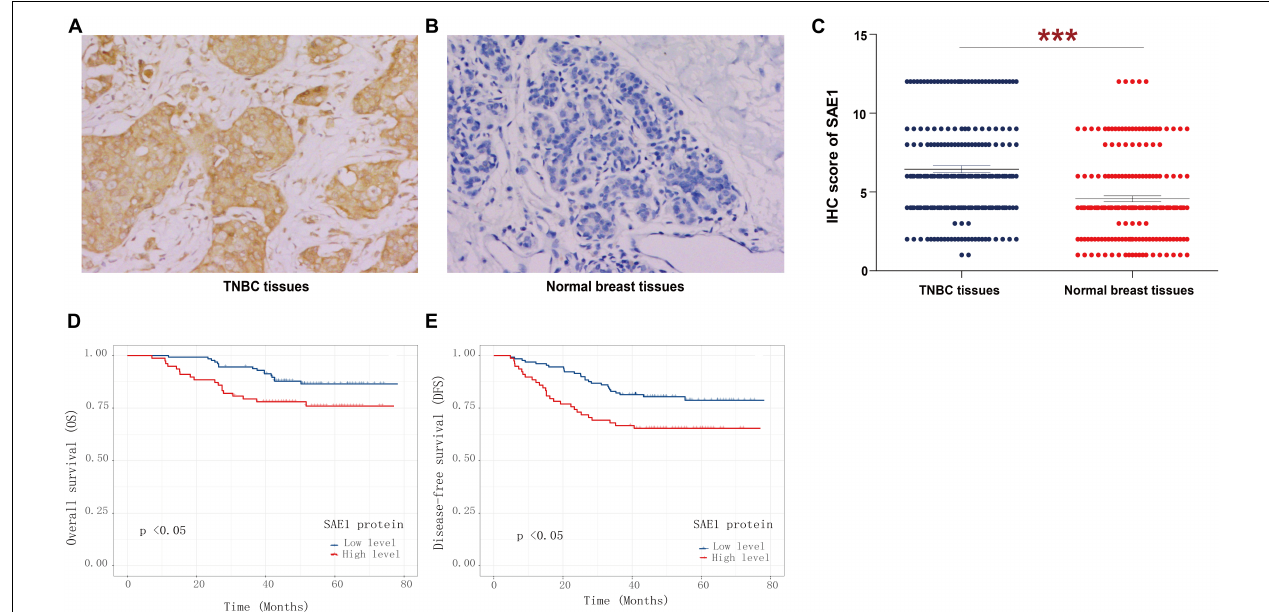
FIGURE 10 | Immunohistochemical (IHC) analyses of SAE1 protein expression in TNBC. Representative IHC images of SAE1 protein expression in TNBC tissues (A) and normal breast tissues (B) . (C) Histogram of IHC score for SAE1 in TNBC patients. (D,E) The prognostic value of SAE1 protein expression for OS (D) and DFS (E) in TNBC patients by Kaplan-Meier analysis. *** p <